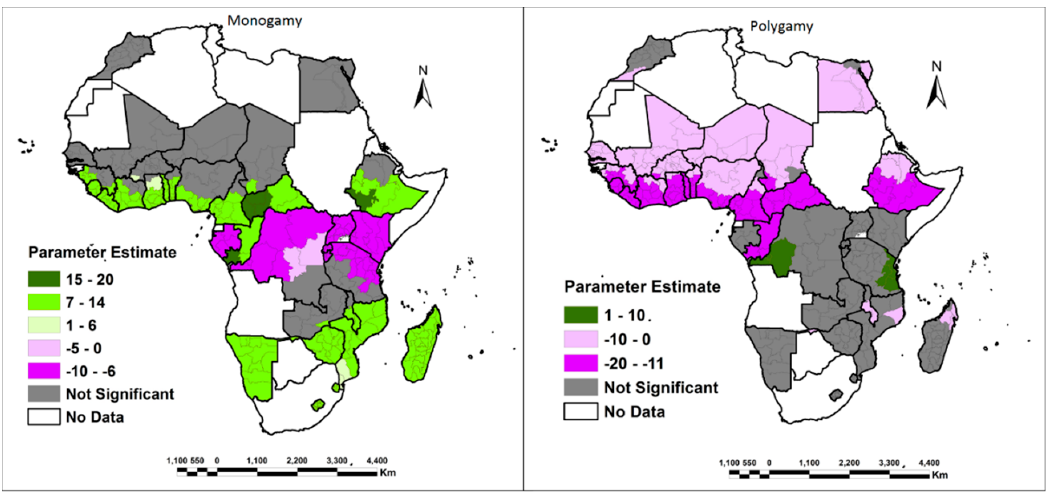
Figure 11. Spatial distribution and significance of monogamous/polygamous relationships on women’s access to own land.